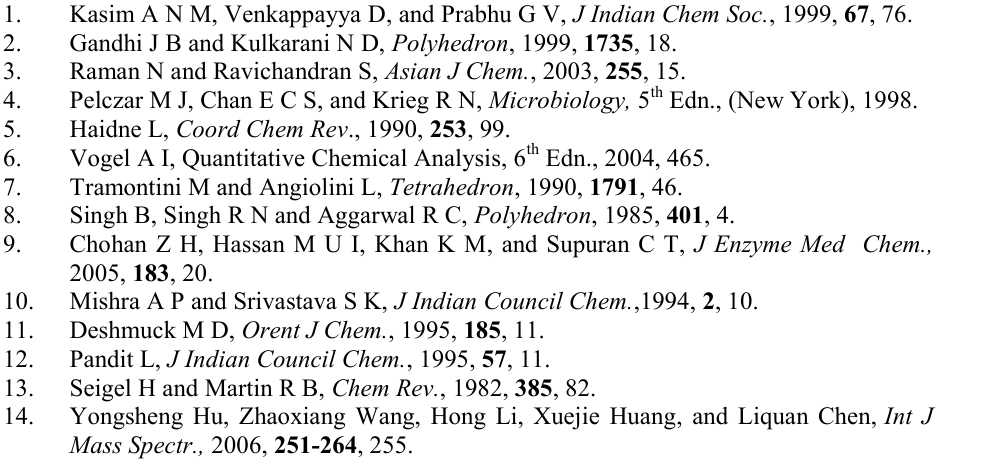
) .MBA (A= Co, Ni and Cu). 3 2